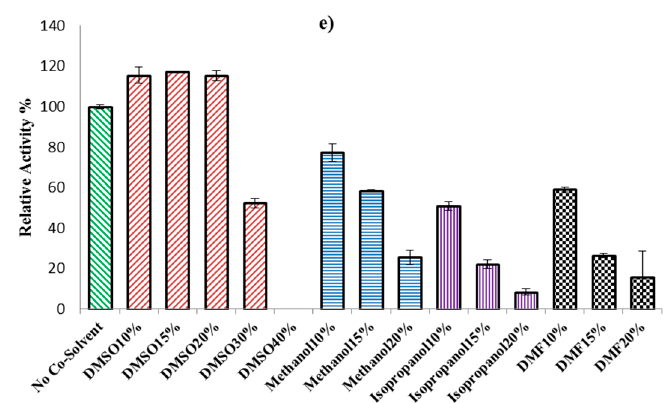
Figure 2. Effect of co-solvent on ω -TA activity of screened strains. ( a ) BaH; ( b ) BaE; ( c ) BaS; ( d ) RhZ; ( e ) BaI. The value of 100% corresponds to enzyme activity in the no co-solvent condition. 1 mg/mL cell-free extract was added to react under the following conditions: ( S )-MBA (10 mM), pyruvate (10 mM), PLP (0.1 mM), and co-solvent (0–30% v / v ) in Britton–Robinson bu ff er (pH 7) at 35 ◦ C. Formation of acetophenone was detected by HPLC at 254 nm. Error bars represent ± standard